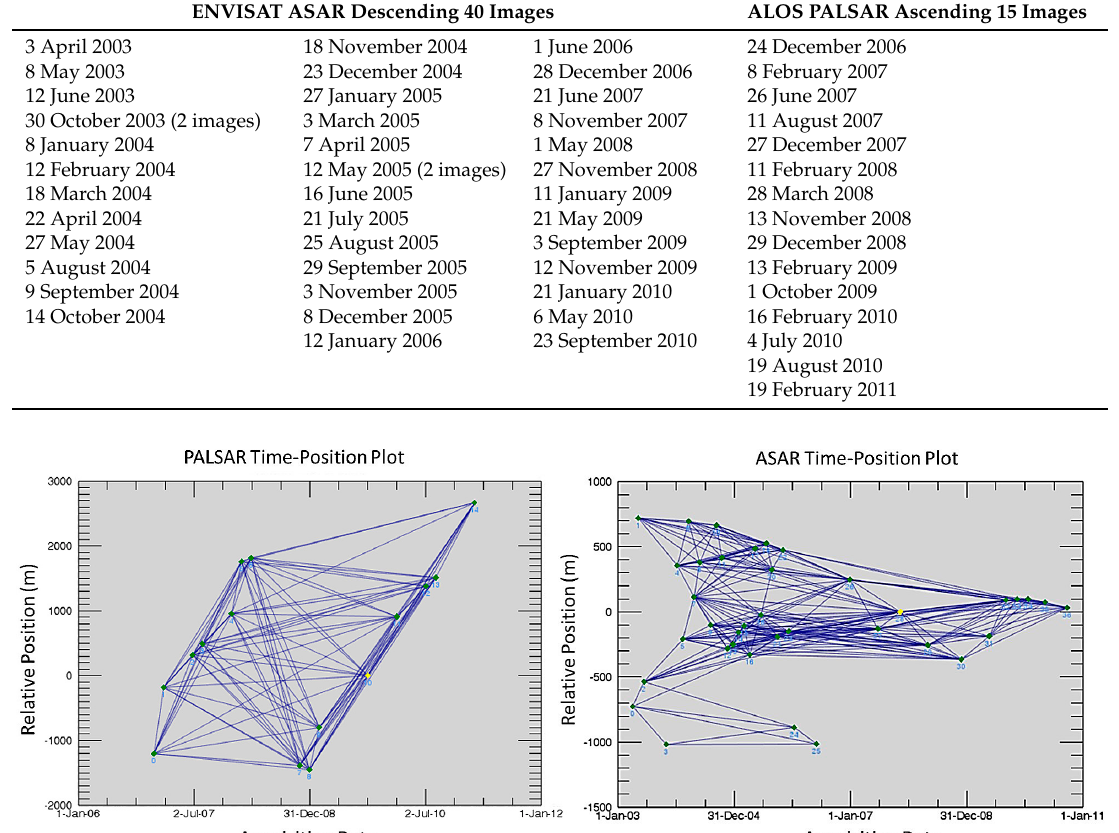
Table 1. A list of Environmental Satellite (ENVISAT) Advanced Synthetic Aperture Radar (ASAR) and Advanced Land Observing Satellite (ALOS) Phased Array L-band Synthetic Aperture Radar (PALSAR) images used in Small Baseline Subset (SBAS) approach.